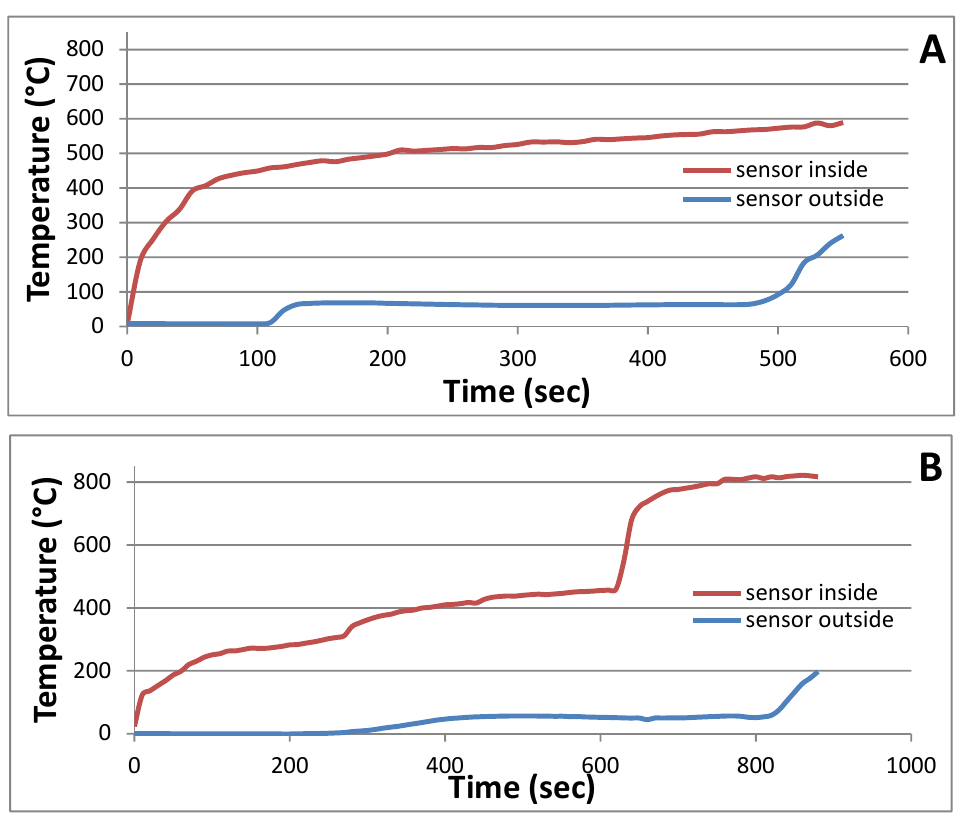
Figure 8. Burning characteristics of produced panels: ( A ) Rapid temperature increase; ( B ) gradual temperature increase.